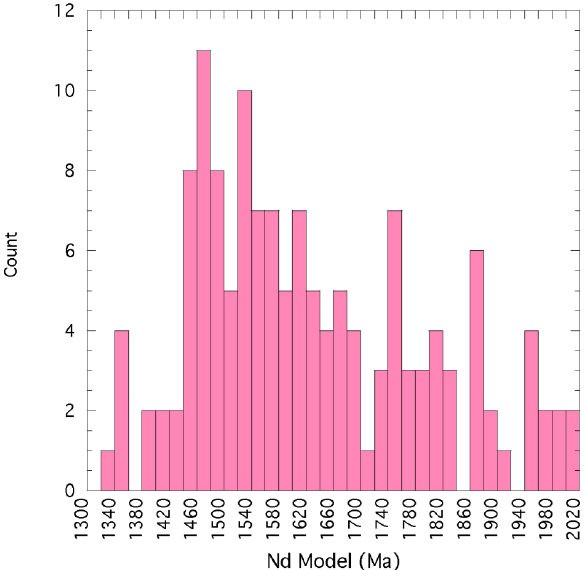
Figure 4. Nd model ages of granites from Southwestern United States and the Mid-continent region of Laurentia. Data compiled in Appendix